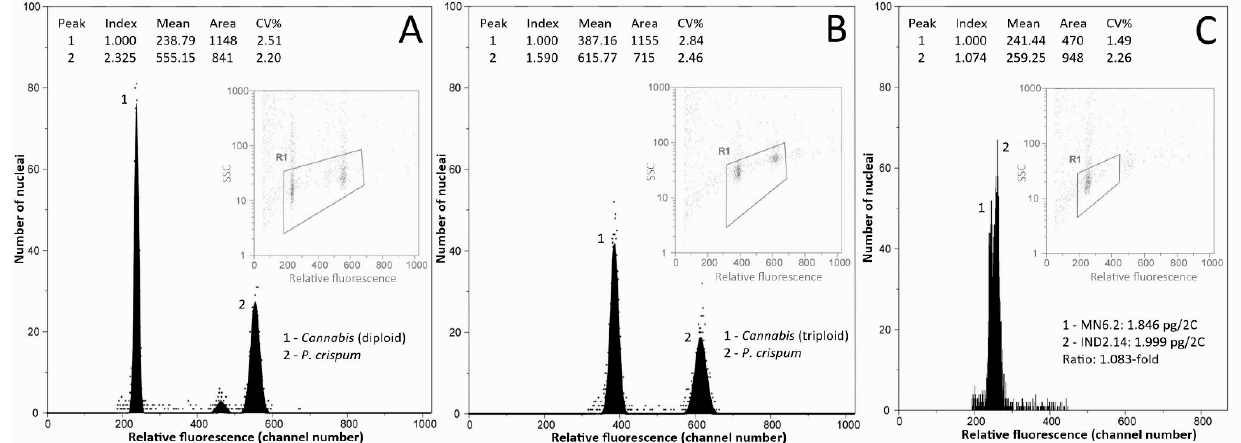
Figure 2. Flow histograms obtained from analysing ( A ) diploid Cannabis individual (accession KAZ, Kazakhstan) (peak 1) and ( B ) triploid Cannabis individual (accession IND1, North India), using Petroselinum crispum (4.5 pg/2C, peak 2) as the internal standard. ( C ) Flow histogram obtained from co-processing diploid individuals from accessions MN6 (Mongolia) and IND2 (South India). Table 1. Results of ANOVA analysis comparing the effect of accessions, distribution areas, and sex on genome size values of Cannabis